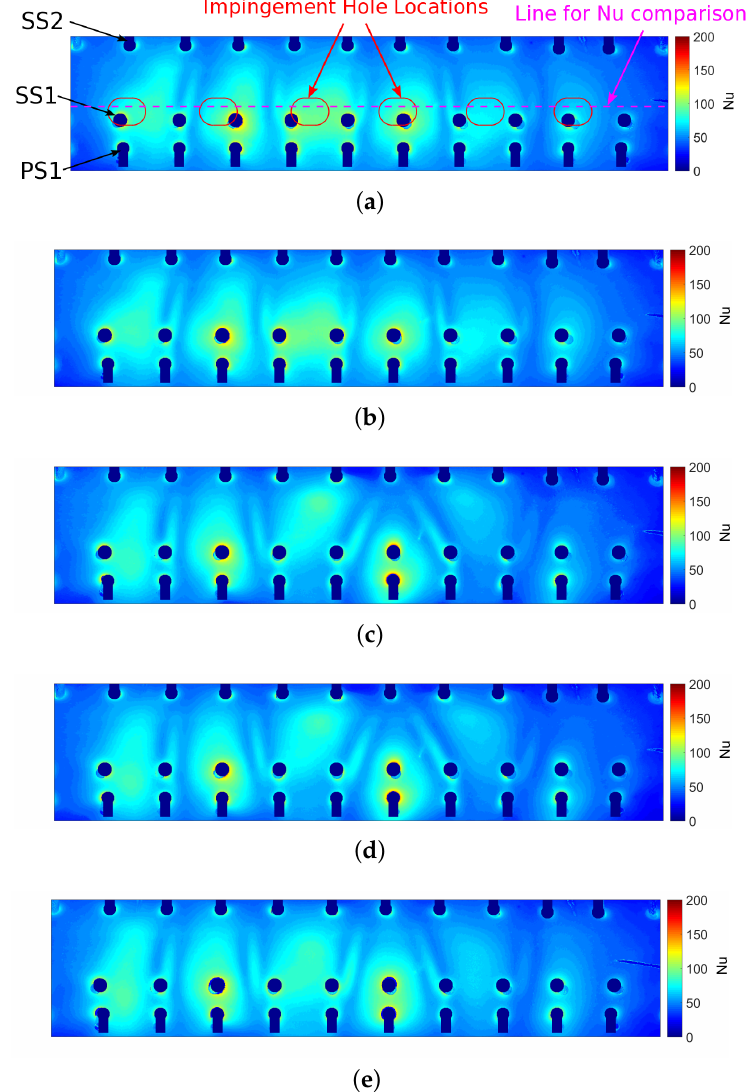
Figure 5. Comparison of measured Nusselt number distributions for all geomtries at Re = 17,500. ( a ) Figure showing Nu map, with indicative impingement hole locations, and film hole labels; ( b ) Geometry 1—single line, racetrack; ( c ) Geometry 2—staggered, racetrack; ( d ) Geometry 3—staggered, elliptical; ( e ) Geometry 4—reduced stagger,